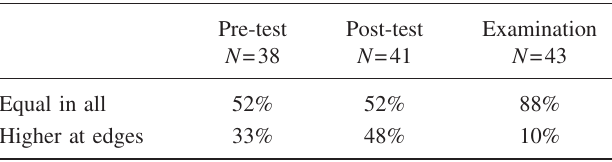
TABLE III. Student responses on the free cart problem.